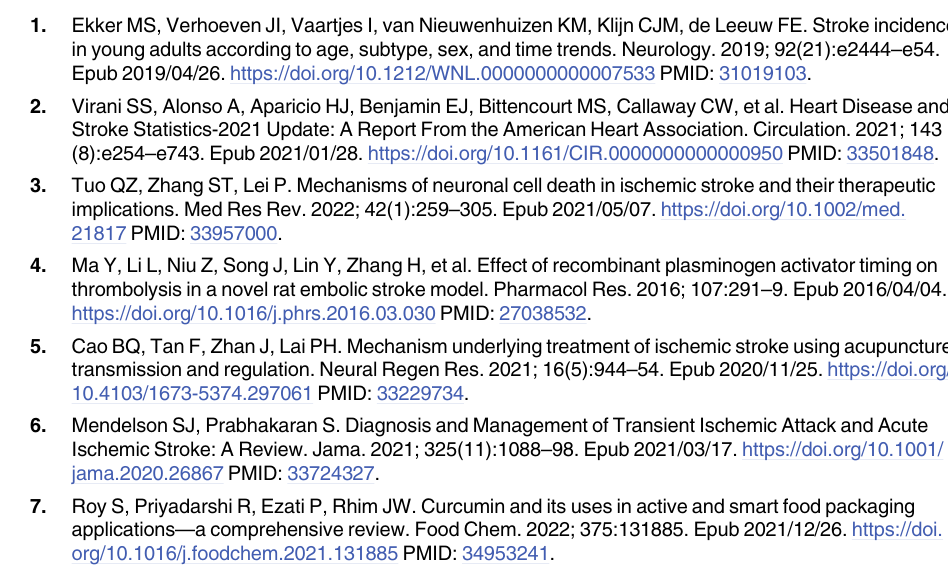
S2 Table. The top 20 pathways of KEGG enrichment analysis.